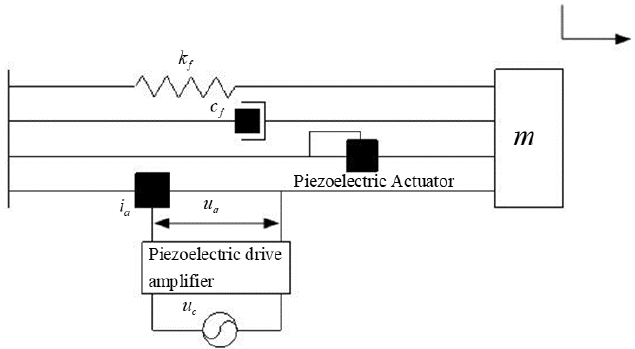
Figure 3. The dynamical model of the piezoelectric sensor-actuator.